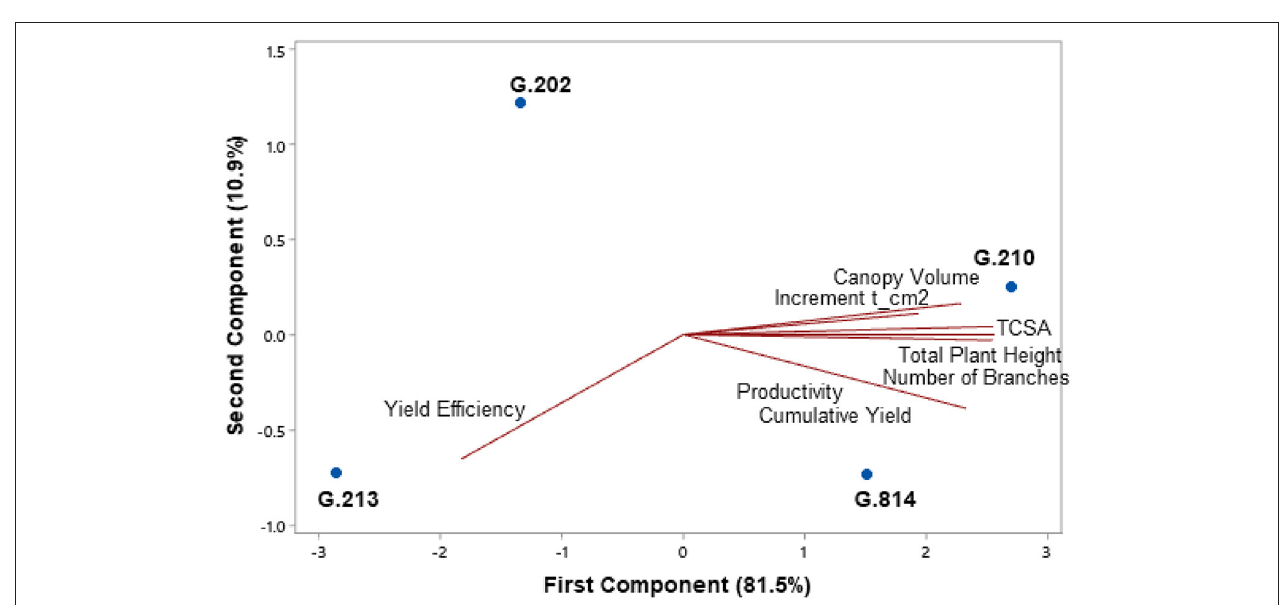
FIGURE 10 | Vigor-productivity-efficiency relationship of the Fuji Suprema cultivar on the Geneva ® series rootstocks. Vacaria -